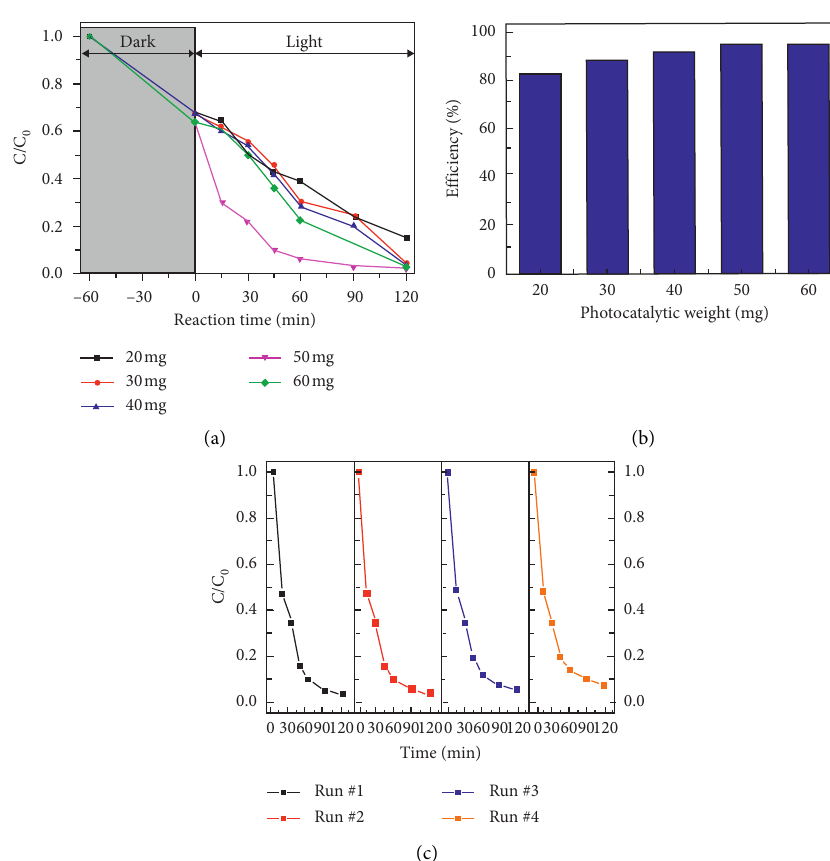
Figure 6: (a) Photocatalytic degradation of MB under visible-light irradiation of Z-7C sample with the different photocatalytic amount. (b) The photocatalytic performance of MB under visible-light irradiation of Z-7C sample on photocatalytic weights. (c) Cyclic performance of the Z-7C photocatalysts towards MB under visible-light Table 2: A comparison of photocatalytic activity of g-C 3 N 4 @ZnO (7%) on the degradation of MB under visible light with recently reported catalysts. Dye conc. Catalyst